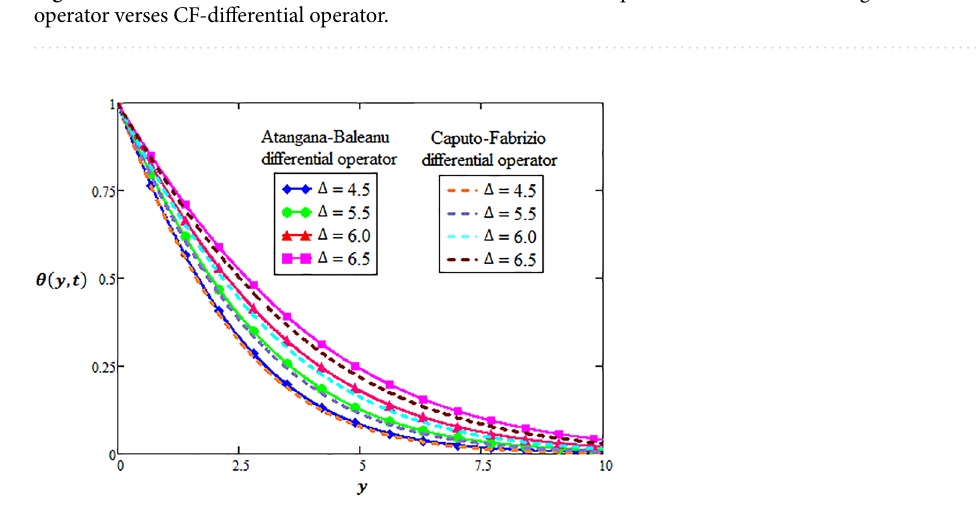
Figure 4. Variation of heat source for two-dimensional velocity profile through AB-differential operator verses CF-differential